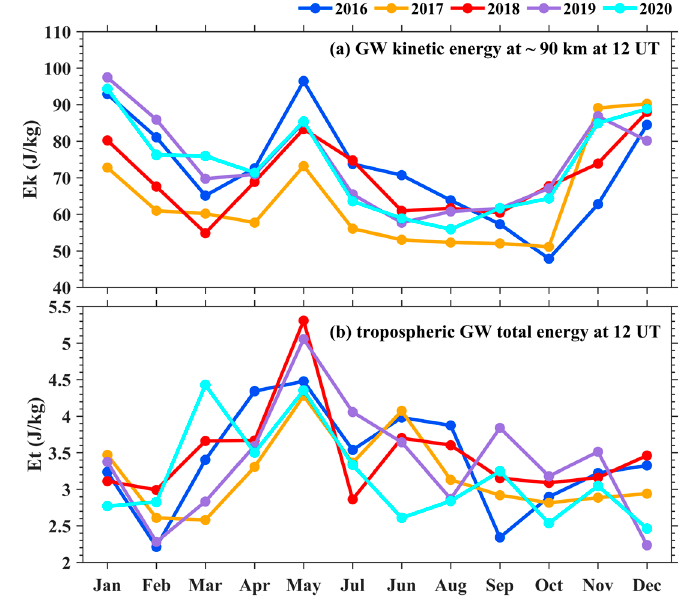
Figure 9. ( a ) Hourly and ( b ) seasonal whisker boxes for the GW kinetic energy Ek .